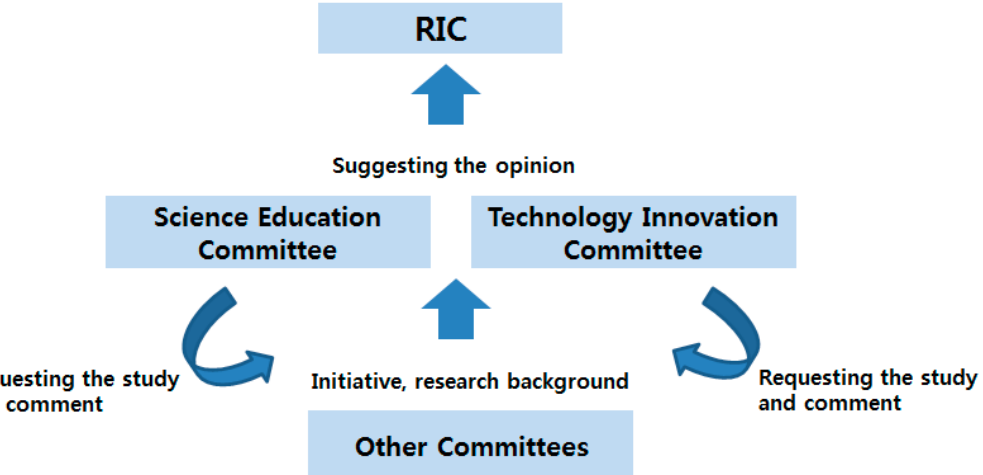
Figure 5. Organization of the Research and Innovation Council (RIC) in Finland.